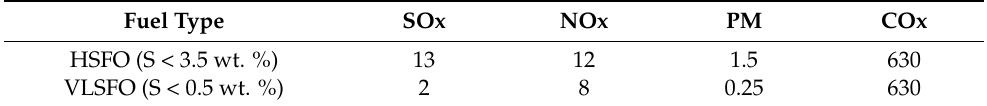
Table 5. Emission coefficients (g/kWh) of different pollutants emitted from burning HSFO or VLSFO. Source: plotted by authors based on data of